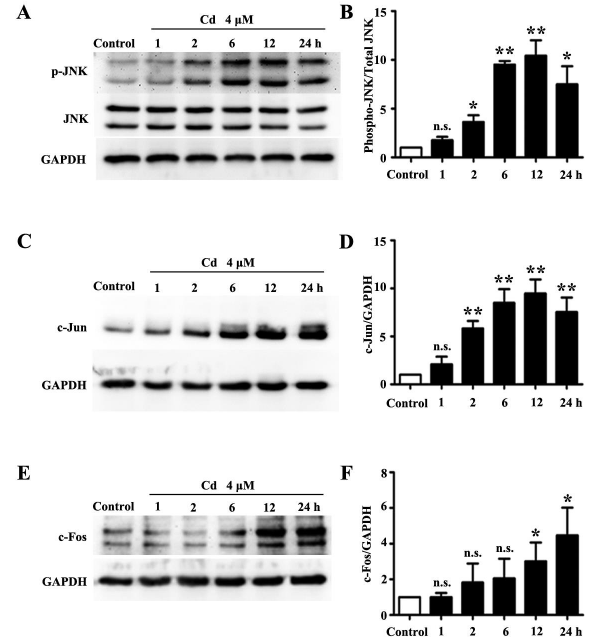
Figure 1. Low dose Cd activates the JNK pathway in human renal mesangial cells (HRMCs). Western blotting analyses from protein samples of HRMCs treated with 4 μM Cd at different time points. The non-treatment samples were used as the control and GAPDH was used as loading control. ( A ) Representative blots of phospho-JNK and total JNK, and GAPDH; ( B ) Densitometry analysis of phospho-JNK/total JNK; ( C ) Representative blots of c-Jun and GAPDH; ( D ) Densitometry analysis of c-Jun/GAPDH; ( E ) Representative blots of c-Fos and GAPDH; and ( F ) Densitometry analysis of c- Fos/GAPDH. n = 3; n.s. non-significant; * p < 0.05; ** p < 0.01.